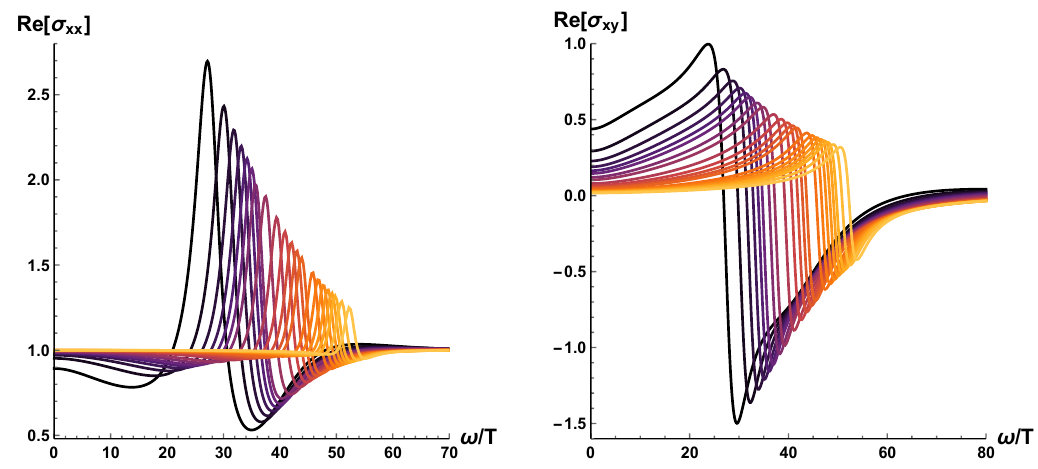
Figure 21 . The evolution of the pseudo-phonon peak increasing the shear modulus. We move the parameter (cid:12) 2 [1 ; 150] (from black to yellow). Other parameters (cid:26)=T 2 = 987 ; (cid:20)=T = 31 : 4 ; (cid:11) = 0 : 1 ; B=T 2 = 10 3 are kept (cid:12)xed.